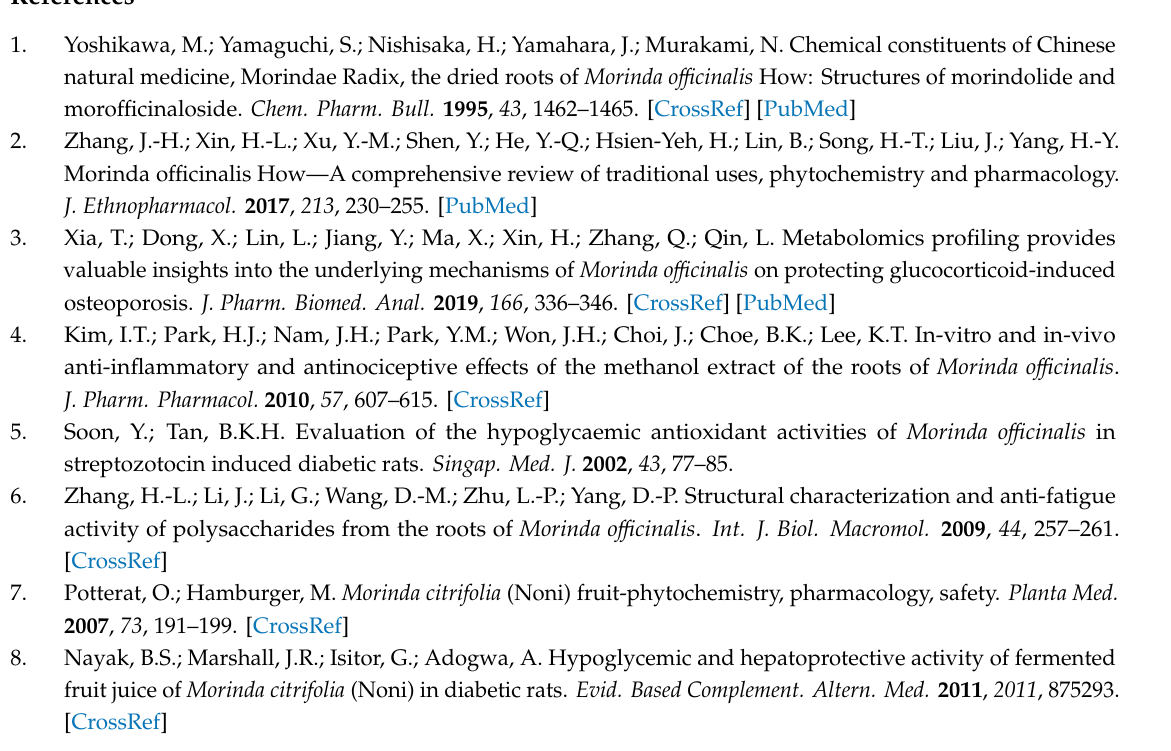
Supplementary Materials: The following are available online. Figure S1: The propose fragmentation pathways of anthraquinones; Figure S2: The propose fragmentation pathways of